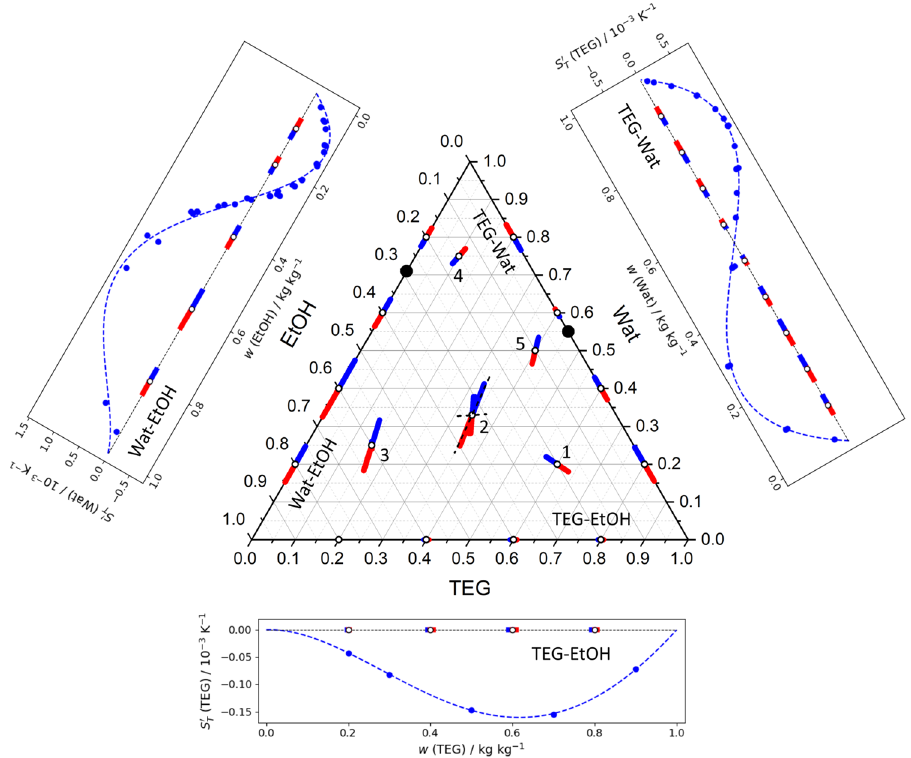
Figure 4. The arrangement of the Soret vectors in binary subsystems and in the TEG–Wat–EtOH ternary mixture at T = 298 K. It follows that the component separation decreases sharply at low water content. The vectors in the state point #2 reflect three different approaches (see Table 1): the smaller vectors for TGC and OBD coincide, and the larger vector presents the ISS results. The thin black dashed lines at the point #2 show the limiting positions of the vector, covering the interval of error bars. The two black circles indicate the sign change of the Soret effect. Note that the values on the axes for the Wat–EtOH and TEG–Wat mixtures are plotted in reverse order to match the axes of the triangle. The symbols on binaries corresponds to the measured points and the dashed curves are intended as guide for the eye. The values of S ′ T ( i ) for the ternary mixture are taken from Refs. 15,28 . The Soret coefficients for Wat–EtOH are from Ref. 25 , for TEG–Wat and TEG–EtOH the authors’ unpublished data 29 , as well as the data of W. Köhler’s group (Uni.Bayreuth) 30